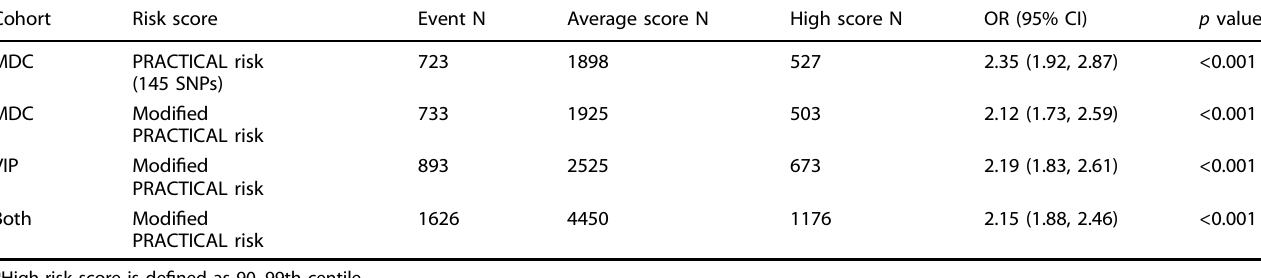
Table 4. Association between high-risk score a vs average risk score b and the outcome of incident diagnosis of any grade prostate cancer. Cohort